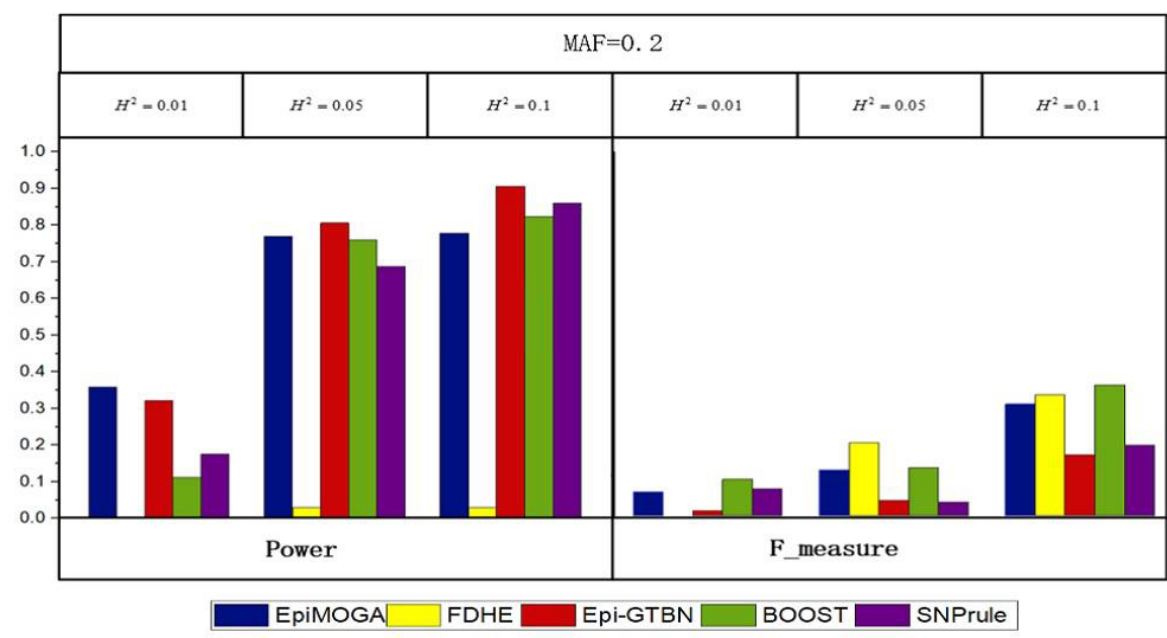
Figure 4. Detection performance comparisons between EpiMOGA and other comparative methods on DNME models with 3 different parameters.